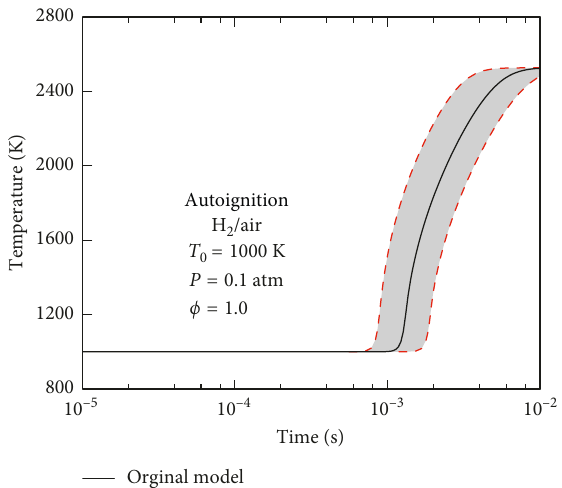
Figure 1: The impact of uncertainties in the rate coefficients on temperature prediction in the autoignition process. The shaded area is the probability distribution of temperature prediction, and ϕ is the equivalence